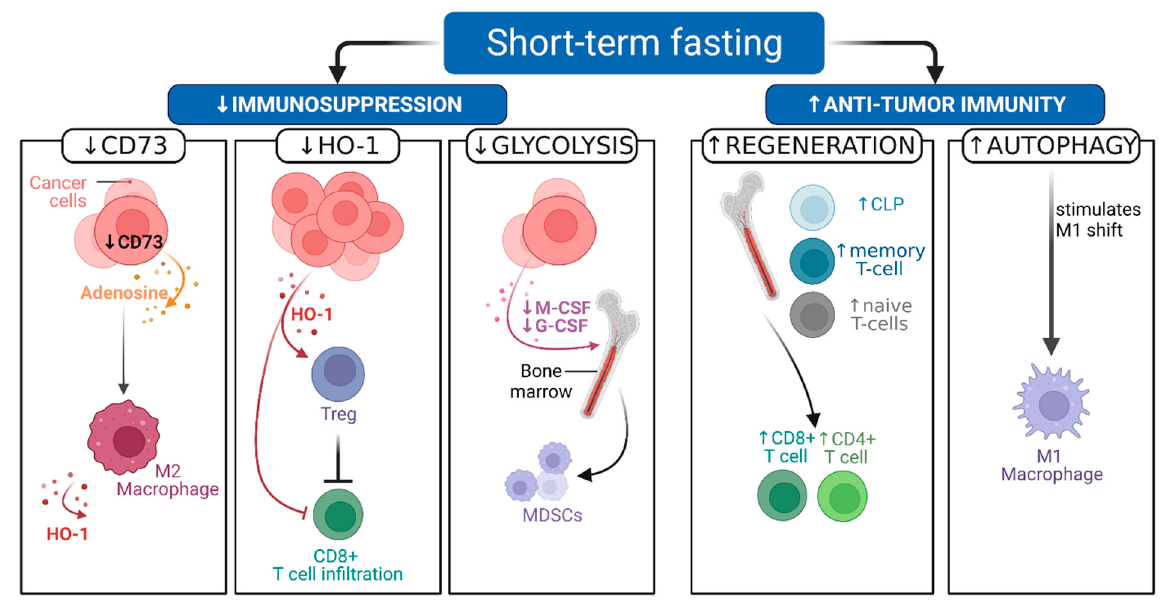
Figure 2. Immunomodulatory mechanisms of short-term fasting [STF] during anticancer therapy. STF reduces immunosuppression and enhances antitumor immunity via the following mechanisms established from preclinical studies: CD73 downregulation in cancer cells causes decreased adenosine release, which in turn diminishes immunosuppressive M2-type macrophage polarization. Decreased heme oxygenase-1 (HO-1) production by cancer cells (and M2 macrophages) releases inhibition of regulatory T (Tregs) cells on CD8+ cytotoxic T cells directly as well as direct inhibition from HO-1. Lowered glycolysis inhibits macrophage and granulocyte colony-stimulating factor (M-CSF, G-CSF) secretion by cancer cells. Consequently less myeloid derived suppressor cells are mobilized from the bone marrow. Hematopoietic stem cell regeneration of common lymphoid progenitors (CLP), naïve T cells and accumulation of memory T cells is observed centrally. Peripheral increase of CD8+ and CD4+ T cells is observed after refeeding and might replenish exhausted T cells as well as increase tumor antigen recognition chance. Autophagy induction stimulates tumoricidal M1 macrophage differentiation, which can support antitumor immunity. Figure 2 is adapted from “Cancer Immunoediting”, by BioRender.com (2022). Retrieved from https://app.biorender.com/